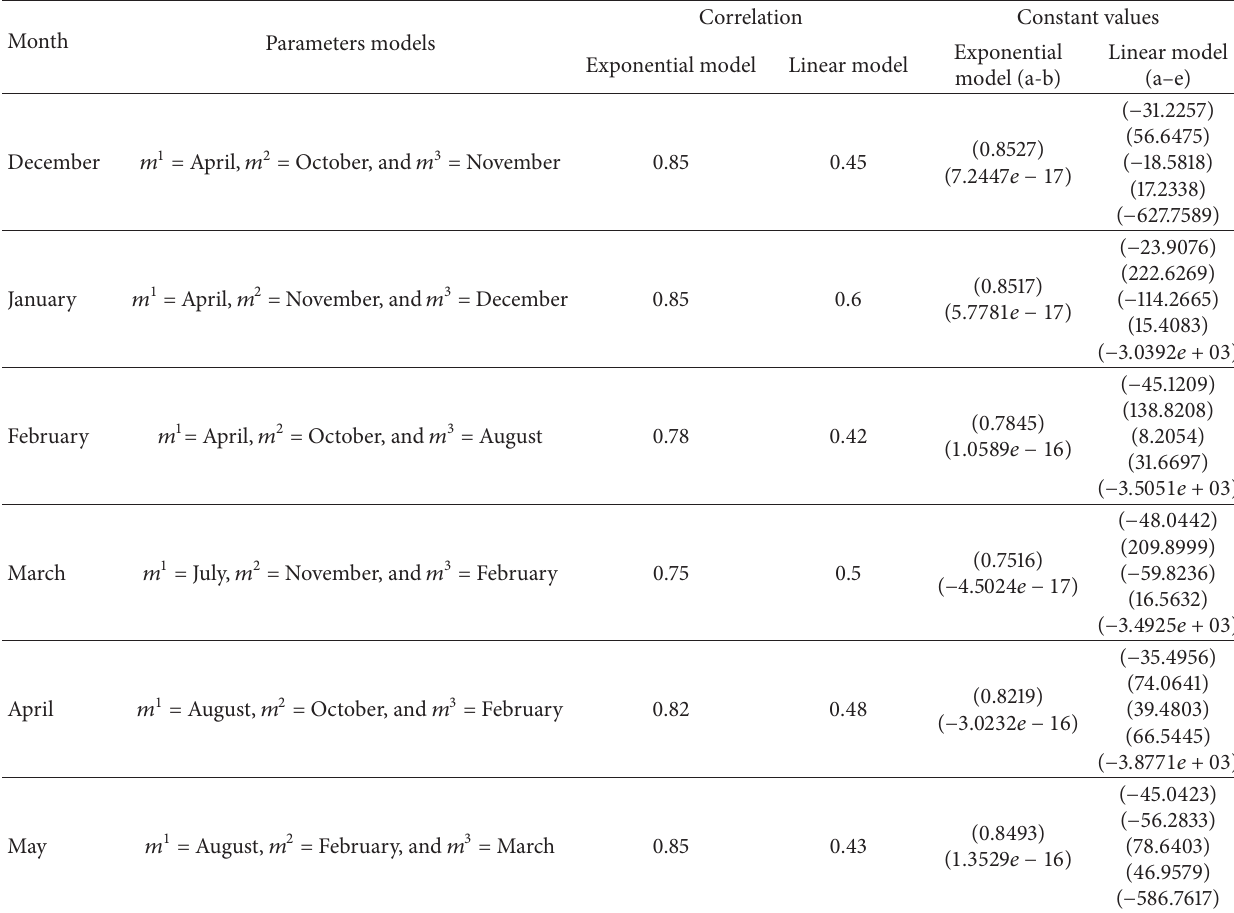
Table 3: Variables and lags used in the linear and exponential models and correlations between modeled and observed rainfall in NW Peru.